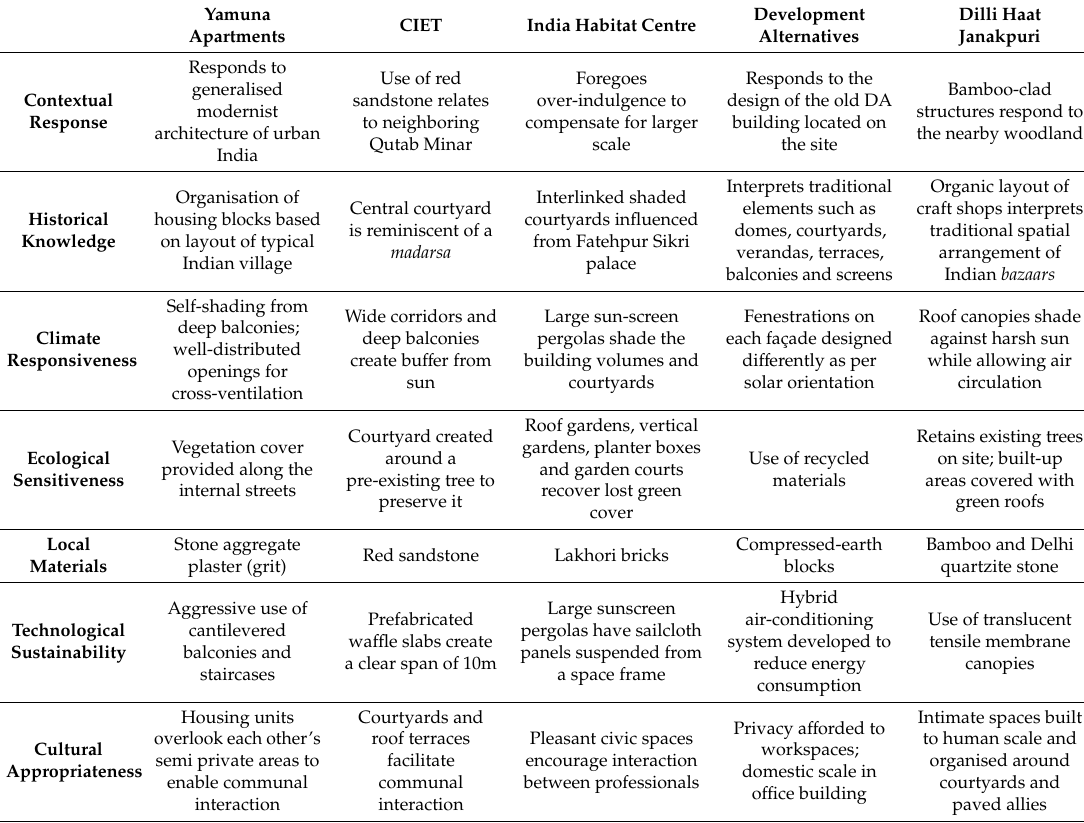
Table 1. Comparison of di ff erent approaches to each aspect of critical